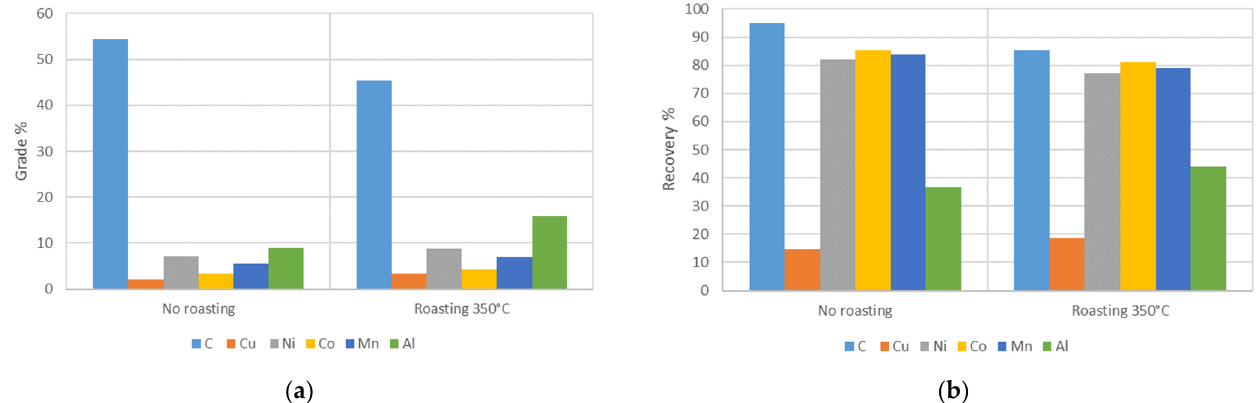
Figure 4. Effects of roasting on grade ( a ) and recovery ( b ) of main components in the flotation concentrate for +0.25 mm fraction.